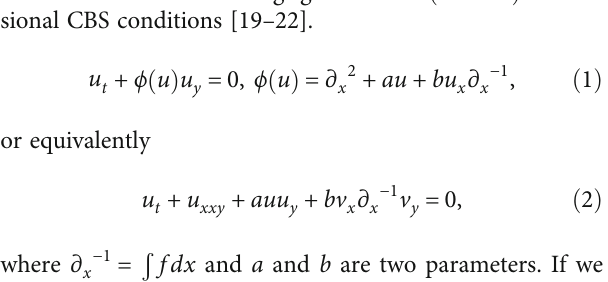
Figure 1: Dynamical behavior of function solution of u